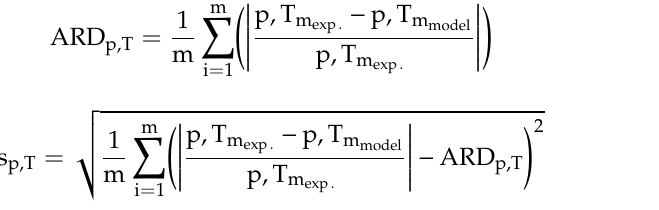
Table 1. Average of the relative deviations (ARD) and standard deviations between the modeled phase equilibria diagram shown in Figures 3 and 4 and the experimental data [32,34,64,65]. Diagram of the Modeled Phase Equilibria